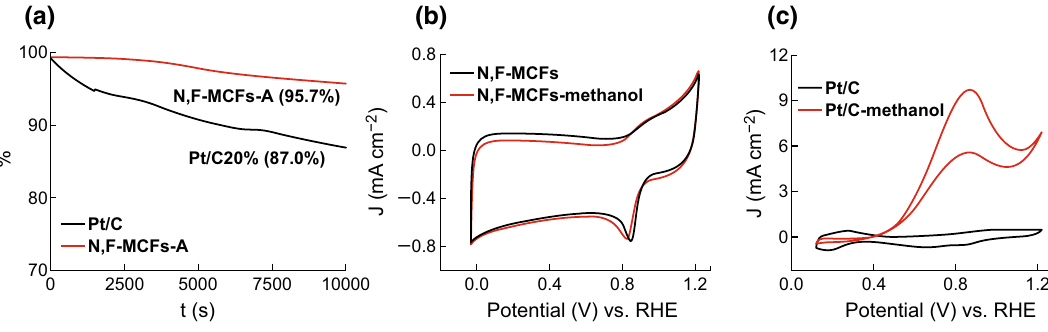
Fig. 6 a Current–time ( i – t ) chronoamperometric response of N, F-MCFs-A and Pt/C 20% in O 2 -saturated 0.1 M KOH at a rotating rate of 1600 rpm for 10,000 s. b CV curves of N, F-MCFs-A and c Pt/C 20% with and without 3 wt% CH 3 OH in 0.1 M